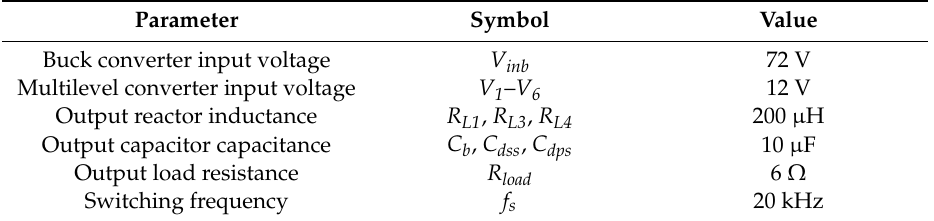
Figure 11. Simulation circuit diagram. Table 2. Specifications and parameters of the simulation circuits.